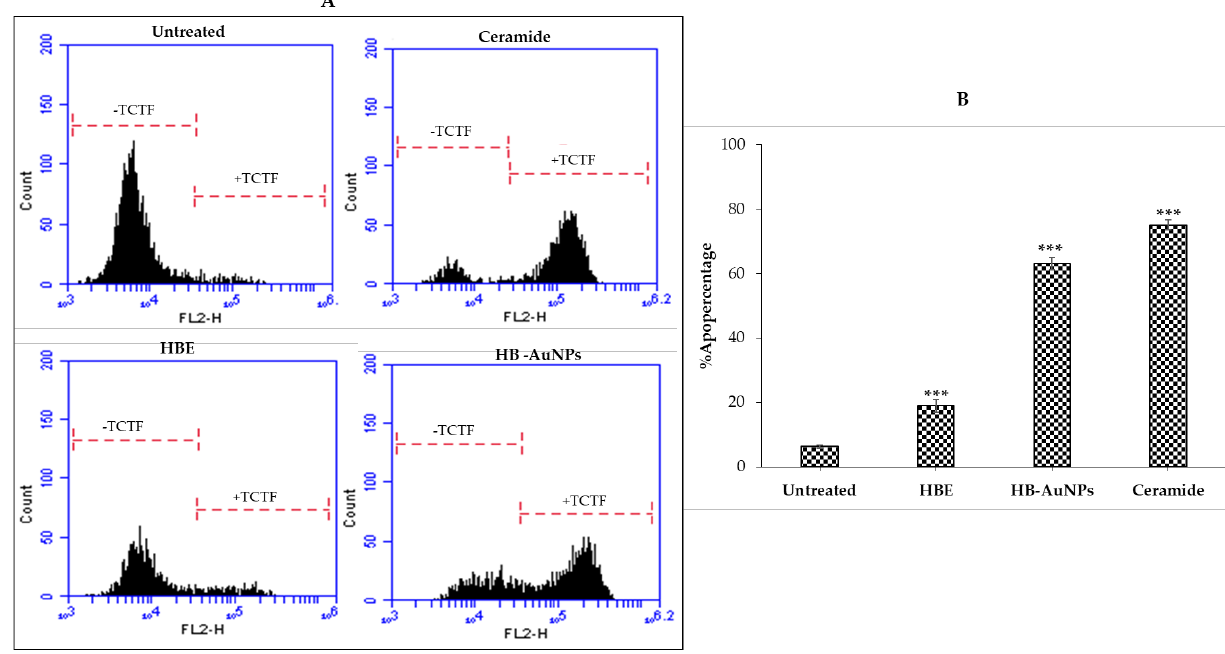
Figure 10. Apoptosis-mediated PC-3 cell death induced by HB-AuNPs. The cells were treated with 1 mg/mL of HBE and 100 µg/mL of HB-AuNPs for 24 h; apoptosis was assessed by the Apopercentage TM assay. Distribution ( A ) and quantification ( B ) of PC-3 cells that were positive for TCTF. − TCTF, unstained cells; +TCTF, Apopercentage TM -dye-stained cells. p < 0.05 was considered to be statistically significant for untreated vs. treated samples. *** p ≤ 0.001.